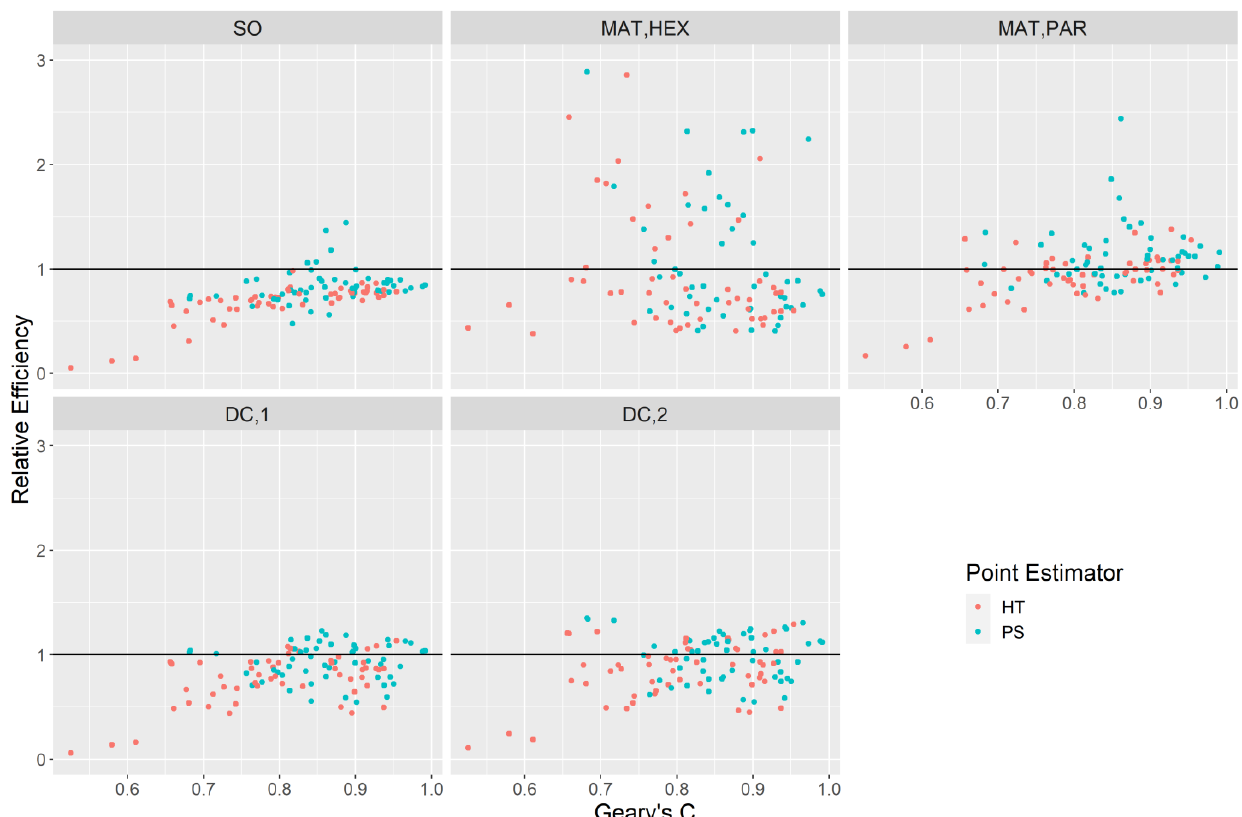
Figure 6. Relative efficiencies of the variance estimators with respect to the SRS estimator under HT and PS point estimation. Each point represents RE attained for one species-specific attribute under a specific point estimator and variance estimator. Table 3. Performance summaries of all variance estimators for the large spatial domain under HT and PS